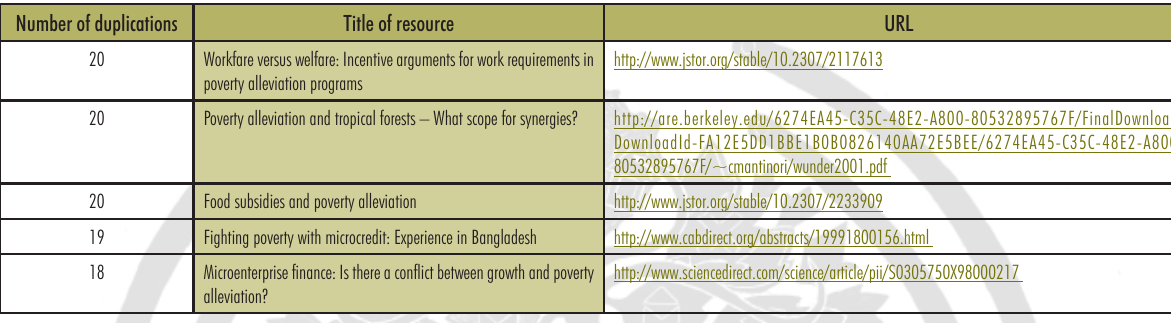
GOOGLE SCHOLAR TOP FIVE RESPONSES FOR POVERTY